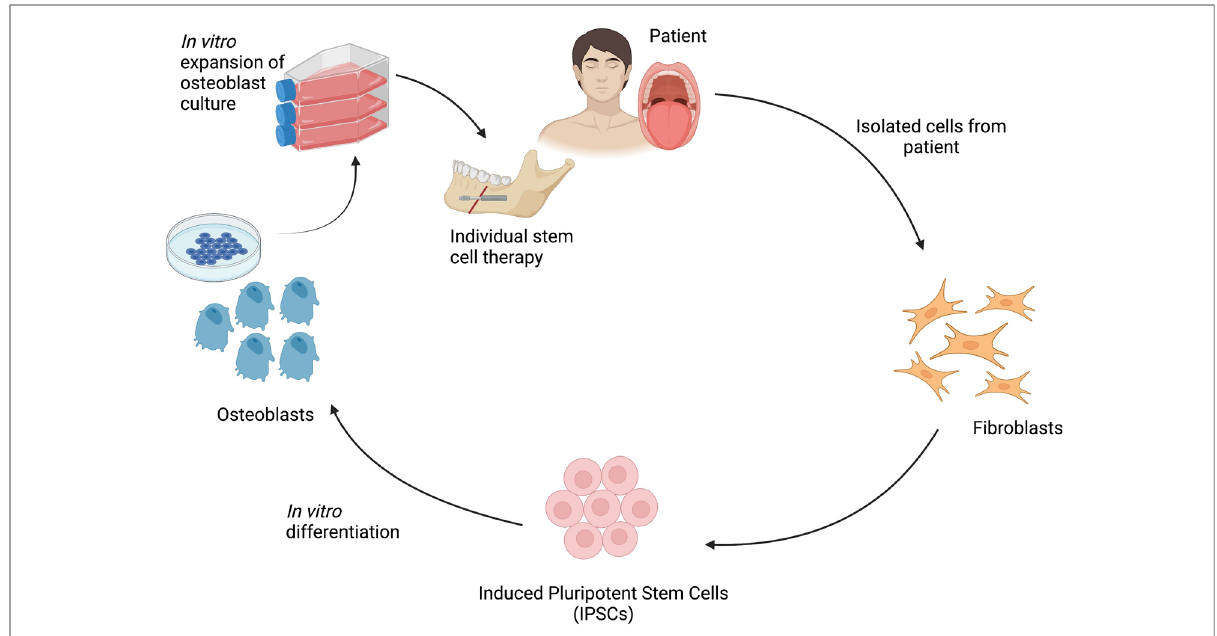
FIGURE 3 Schematic representation of the process of isolation and programming of iPSCs for bone regeneration in dentofacial orthopaedic surgery. Figure created with